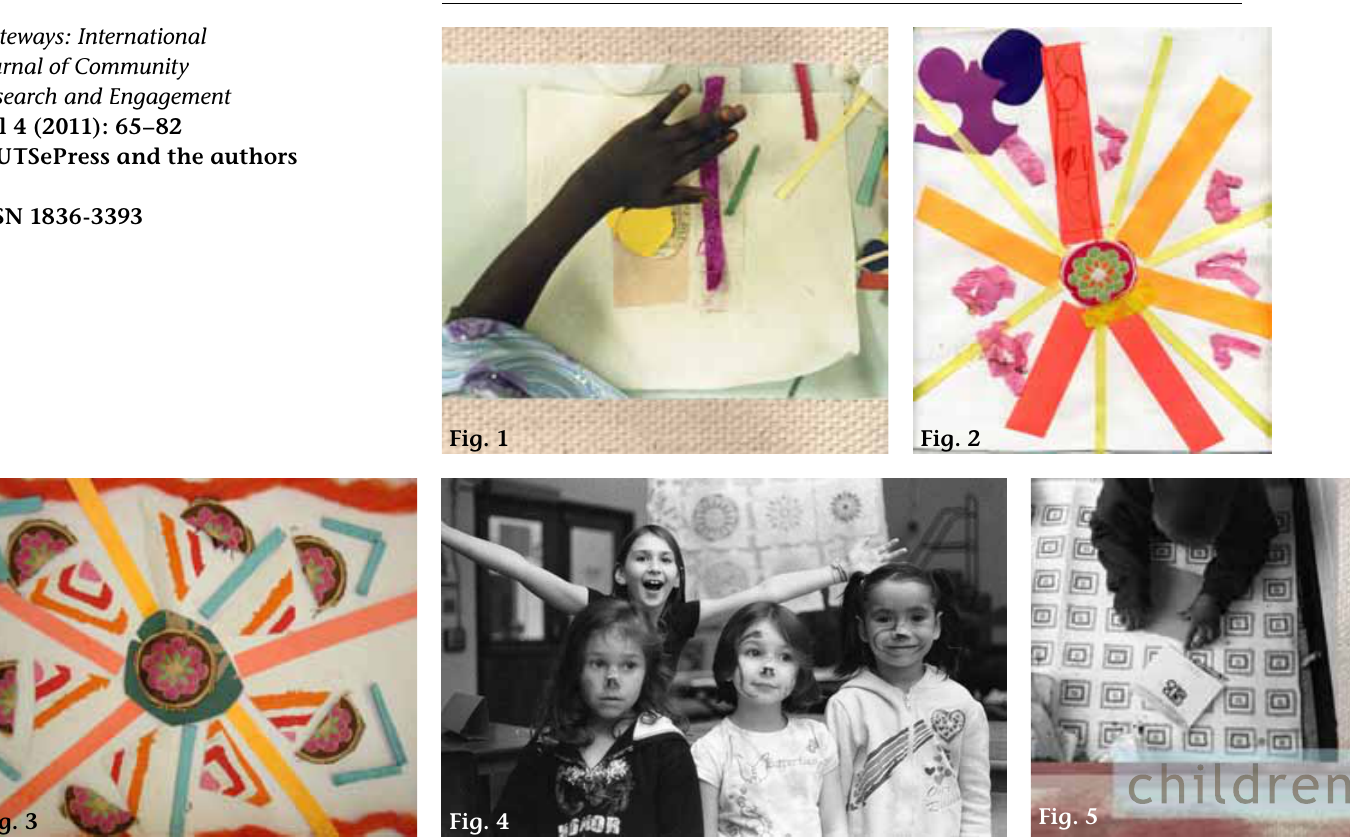
coloured paper (Figure 2). Later, the artist weaves their work into the fabric panel coloured by Khadija’s teacher (Figure 3). This panel and others form the vibrant backdrop of a community celebration, rich with multicultural food, dance, art and music (Figure